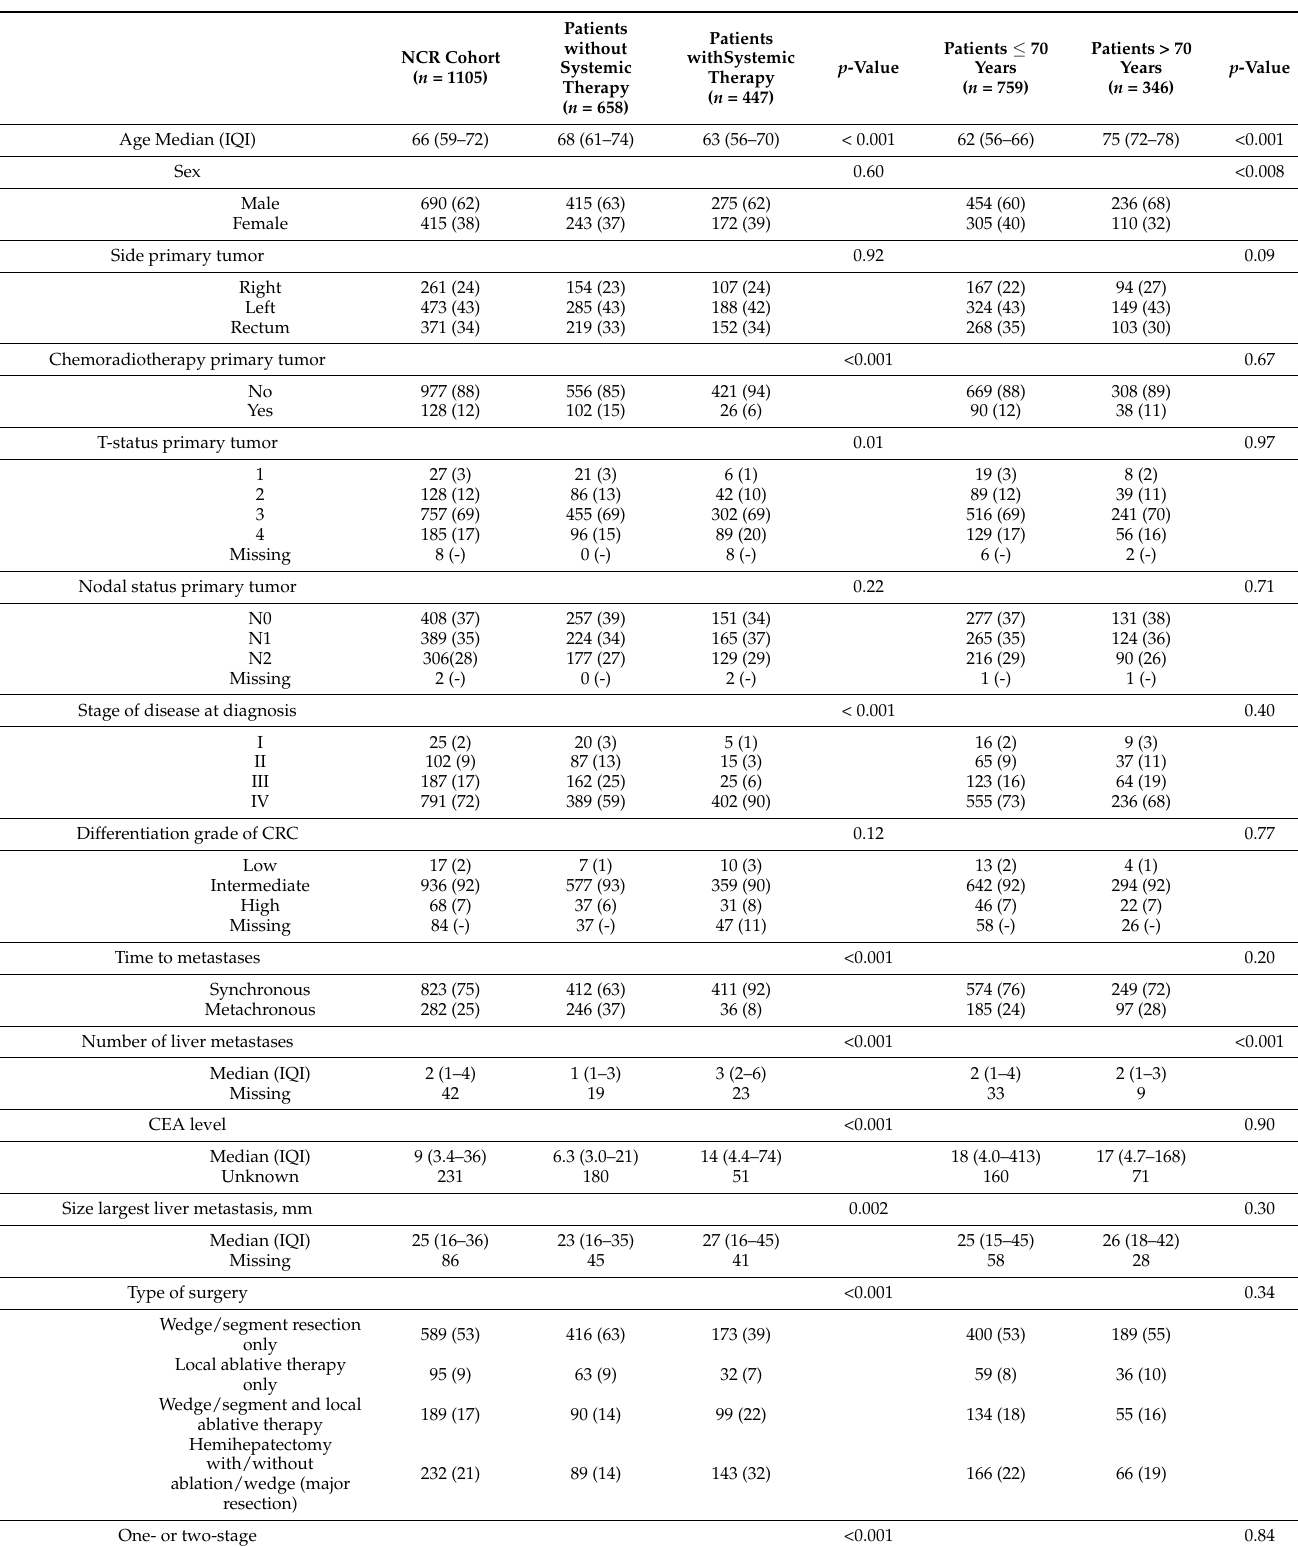
Table 1. Characteristics of total NCR cohort and patients with and without systemic therapy and below or above 70